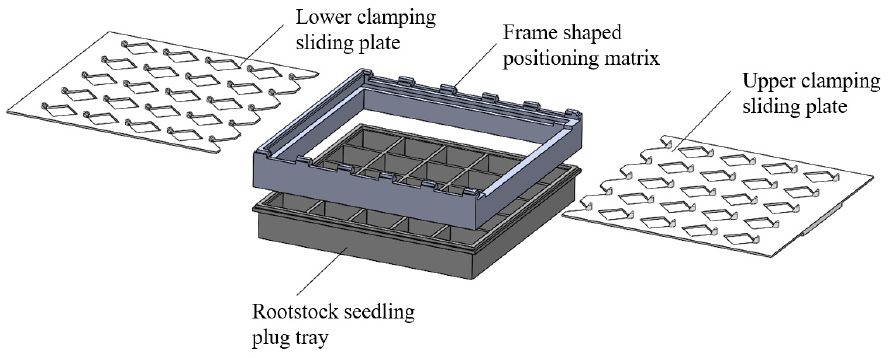
Figure 2. Rootstock clamping and positioning device.